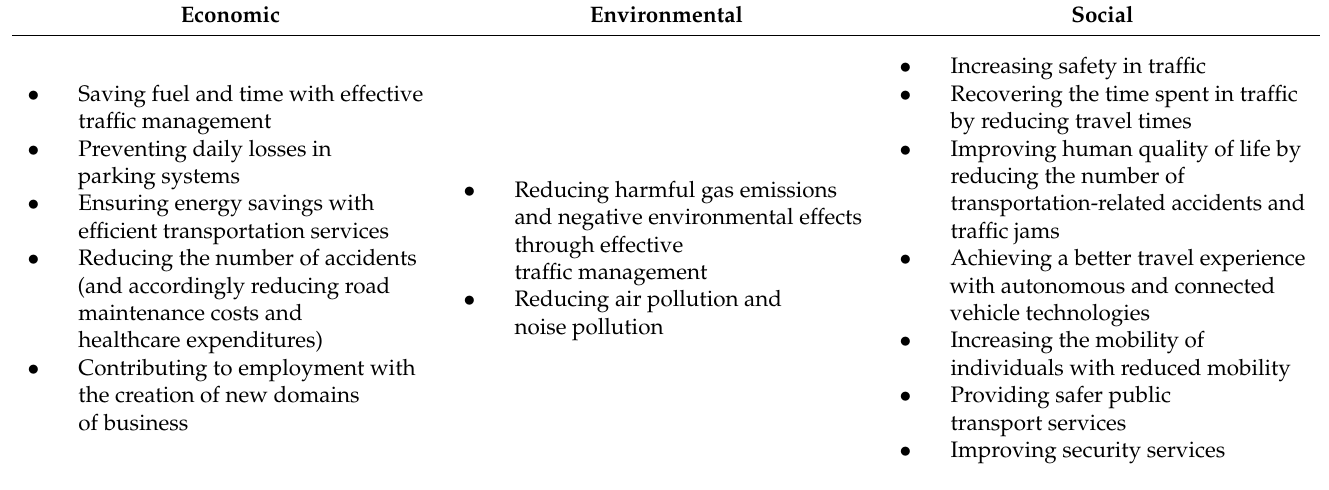
Table 13. Contributions of CV